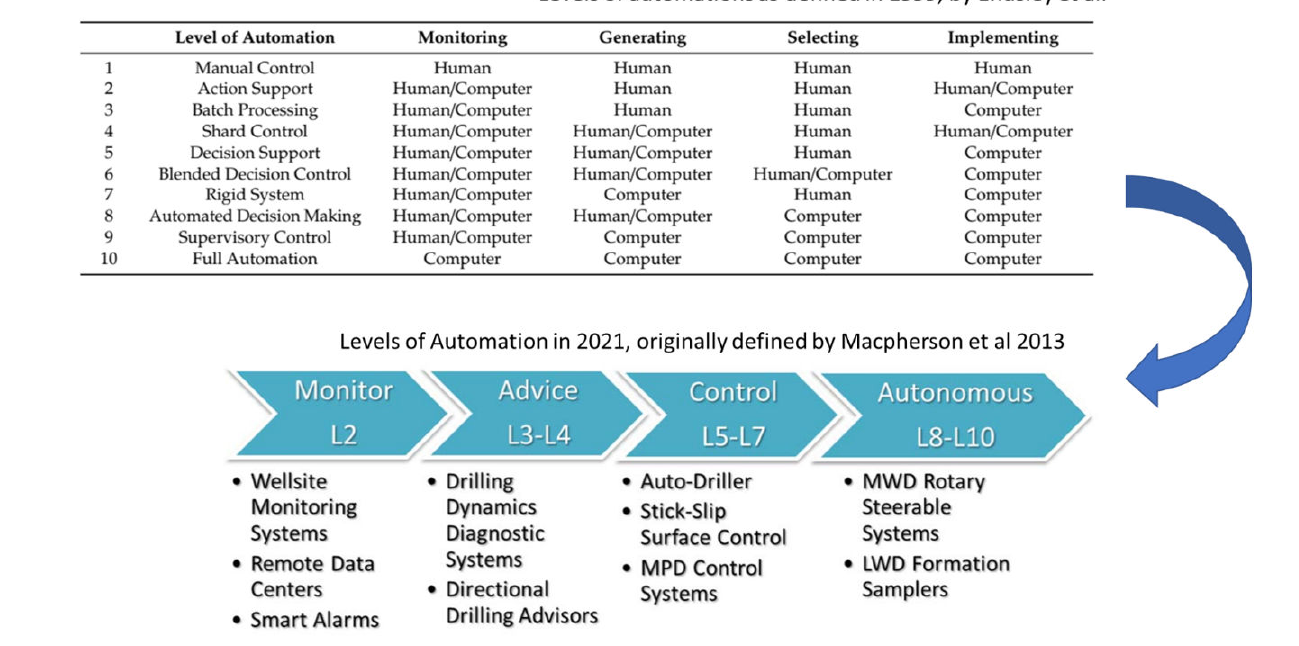
Figure 1. Automation in oil rigs